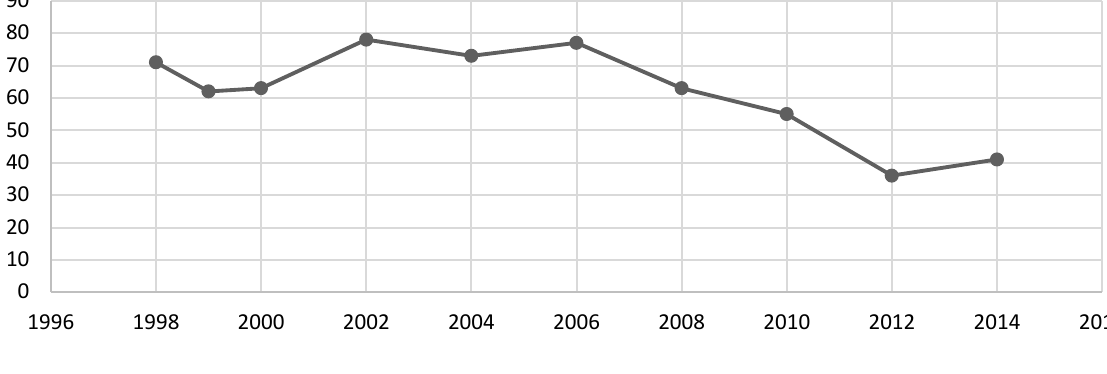
Figure 3. Usage rate of outsourcing